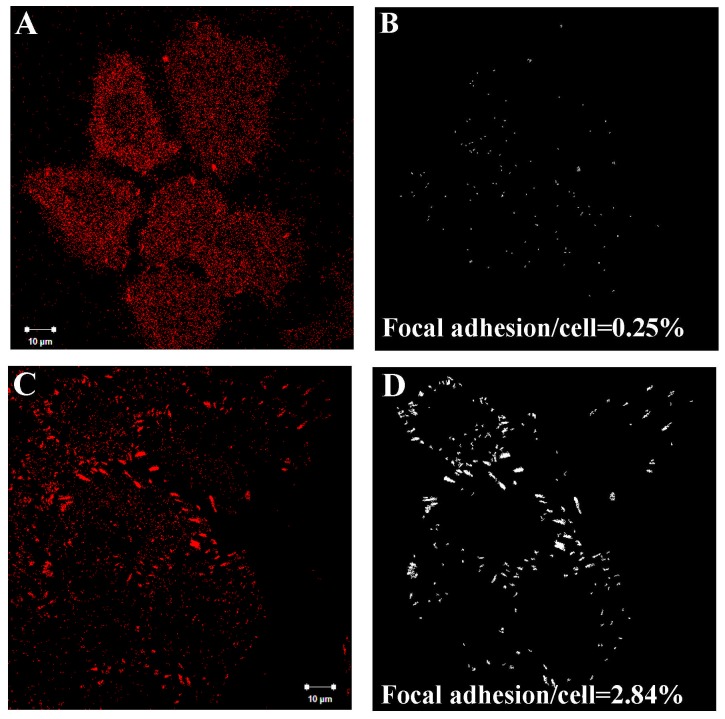
Focal adhesion in HeLa cells without vs. with EHEC infection.Representative confocal micrographs of HeLa cells (A) without- and (C) with- EHEC infection; vinculin was detected by indirect immunofluorescence. The images of focal adhesion were segmented by setting an intensity threshold via MetaMorph software to calculate the fractional area of focal adhesion, as shown in (B) for HeLa cells without-, and (D) with- EHEC infection.